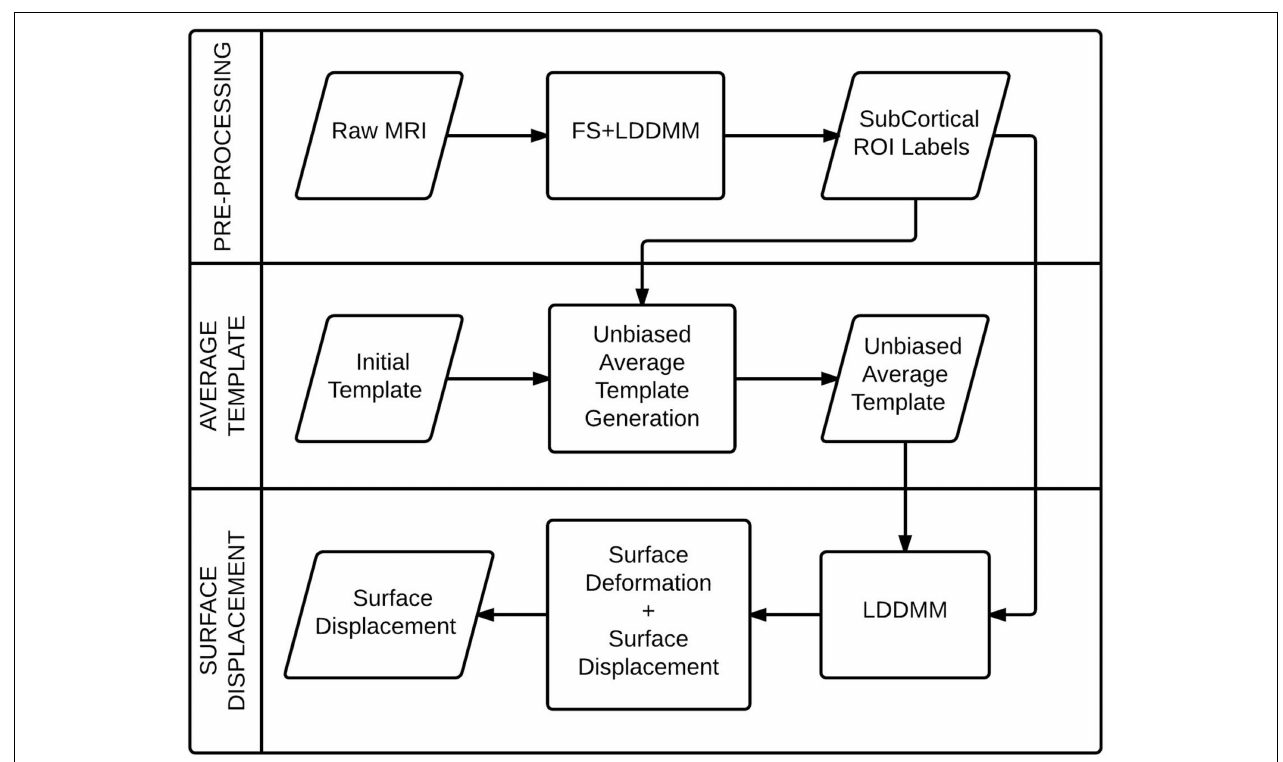
FIGURE 1 | A process flow diagram for the computation of the surface displacement feature from the raw MRI